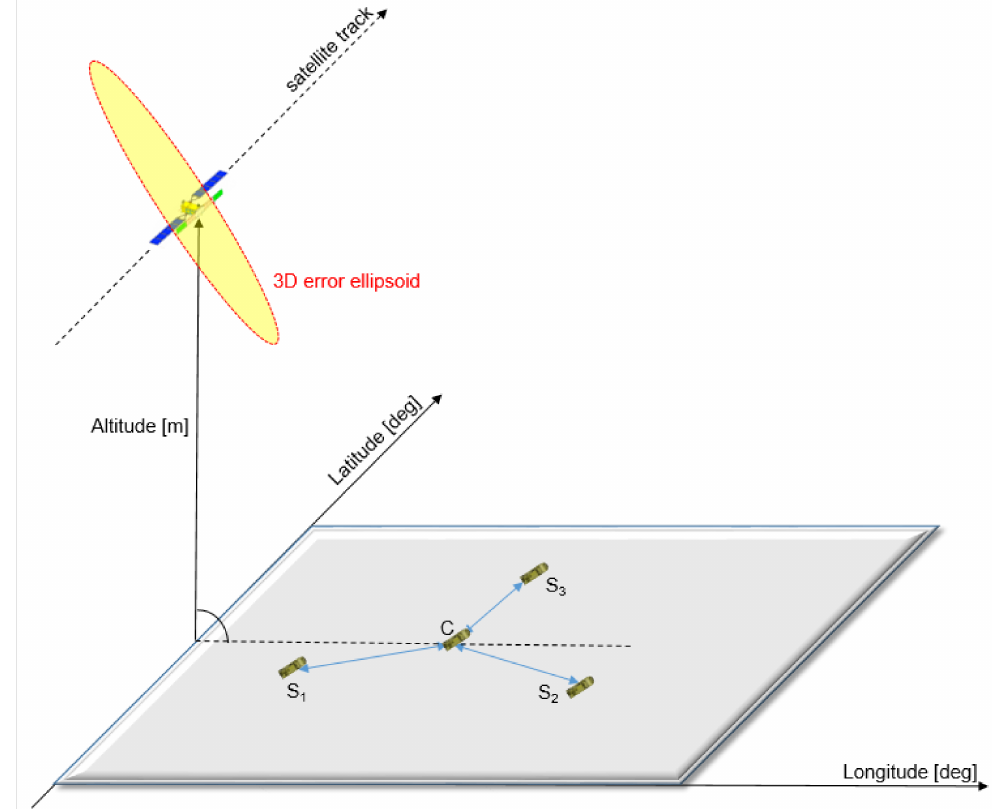
Figure 13. Error ellipsoid to MLAT deployment 3D